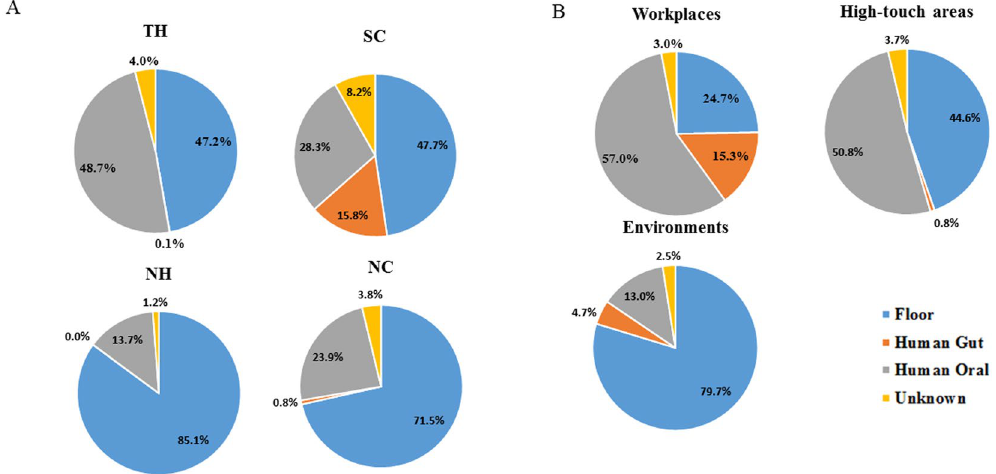
Figure 5. Source environment proportions were estimated using SourceTracker, and the results were shown in pie charts representing the mean proportions for the four healthcare-associated institutes ( A ) and three areas ( B ).